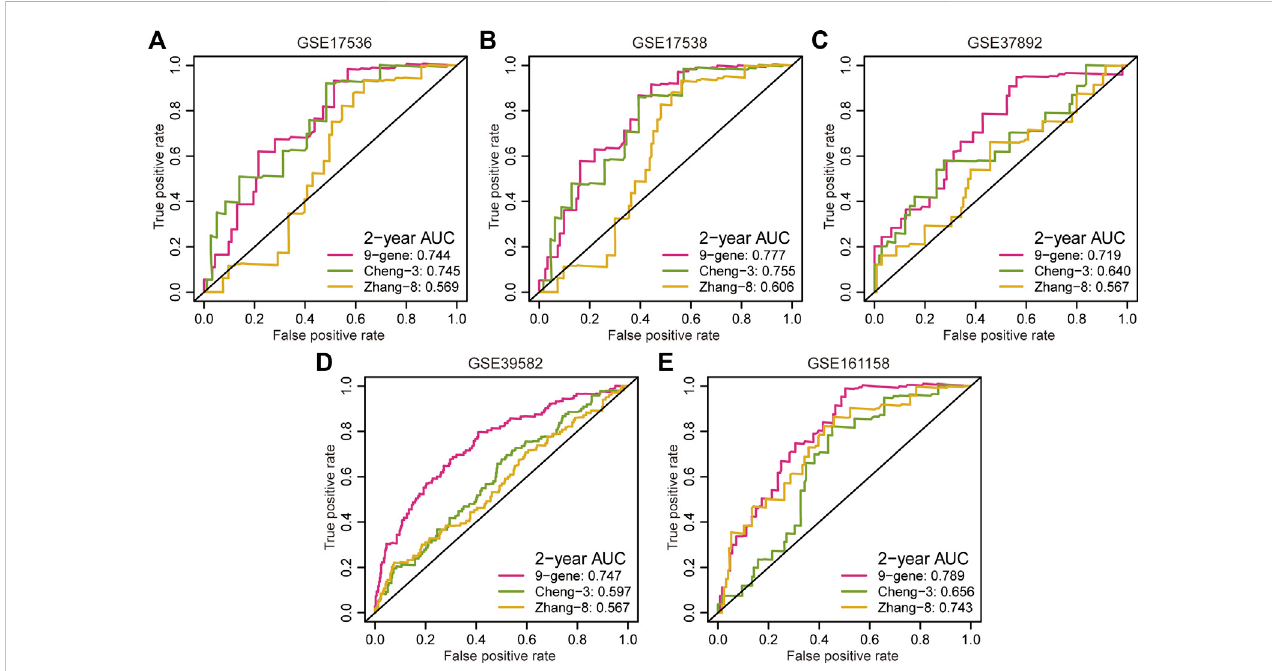
FIGURE 3 Comparison of predictive accuracy between our signature and previous signatures. (A – E) ROC curves investigated the predictive accuracy of gene signatures for 2 year RFS prediction in GSE17536 (A) , GSE17538 (B) , GSE37892 (C) , GSE39582 (D) , and GSE161158 (E) cohorts, respectively.